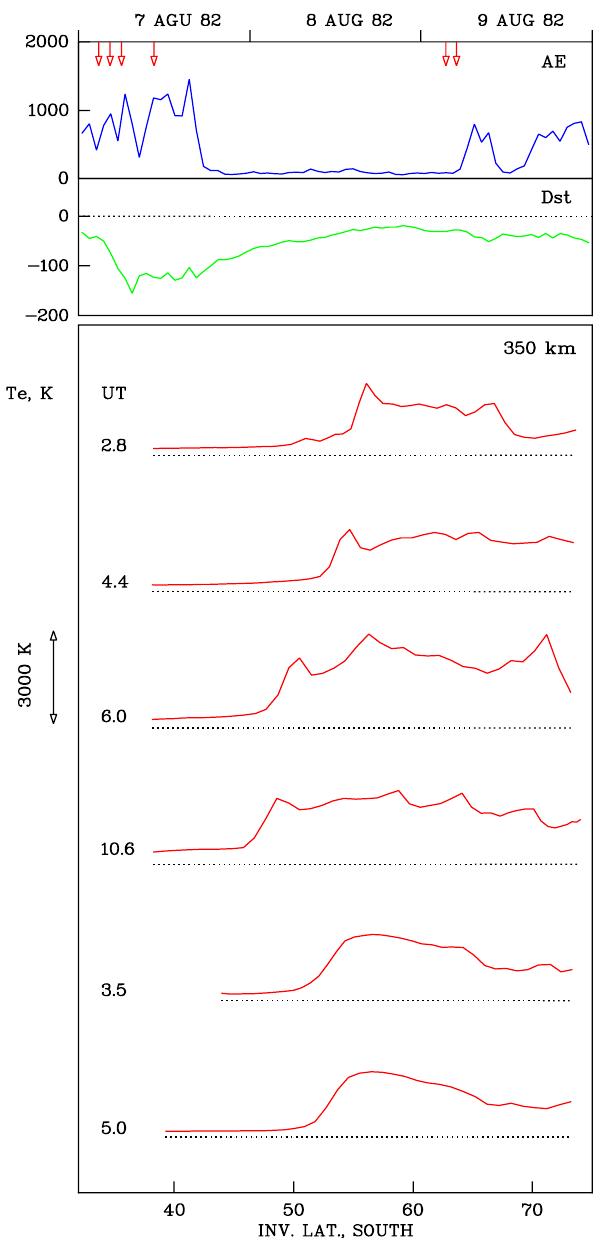
Fig. 17. Residual heating effects during a period of low geomag- netic activity. The format of data presentation corresponds to that of Fig. 15. This time the dotted reference lines mark the 700K tem- perature level. Also, a constant temperature gradient of 1K/km was used in the height adjustment procedure. The solar local time of ob- servation is 03.5h, and the magnetic local time varies between 00.6 and 02.4